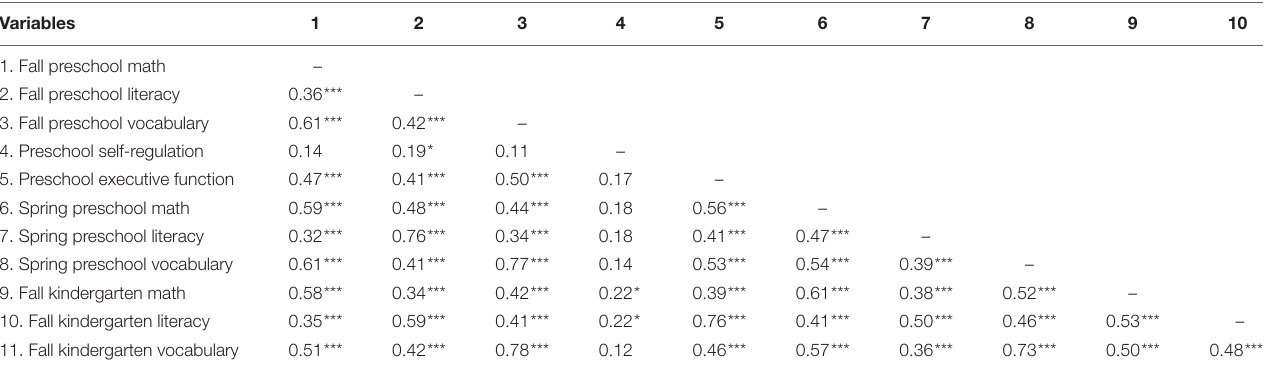
TABLE 2 | Correlations between primary study variables ( n = 126).